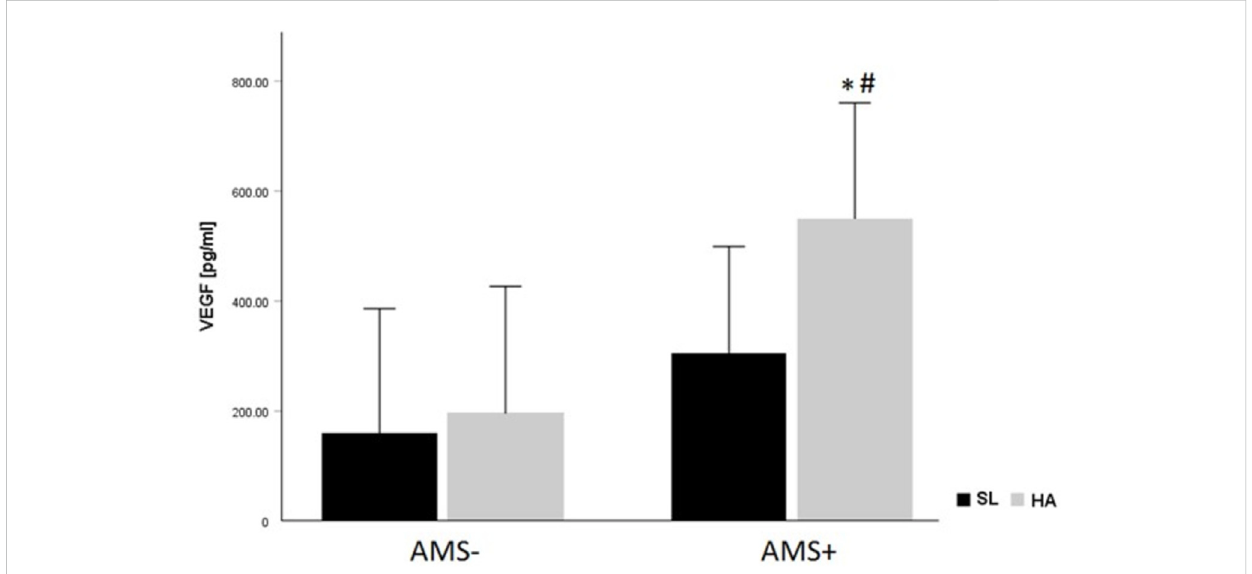
FIGURE 2 VEGFlevels(pg/mL)accordingtoaltitudeandAMSgroup.Dataaregivenasmean±standarddeviation;* p < 0.05forintra-groupcomparisons(SLvs. HA) tested by paired t -test. # p < 0.05 for inter-group comparison (AMS- vs. AMS+) at sea-level (SL) and at high-altitude (HA) using unpaired t